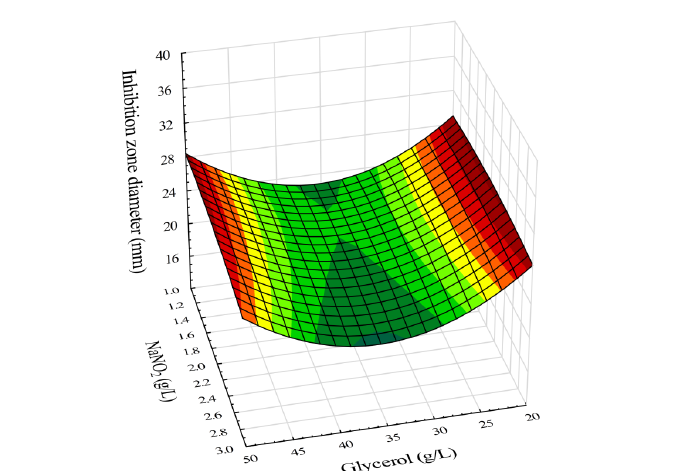
FIGURE 3 - The effects of glycerol and NaNO content of 10 g/L.